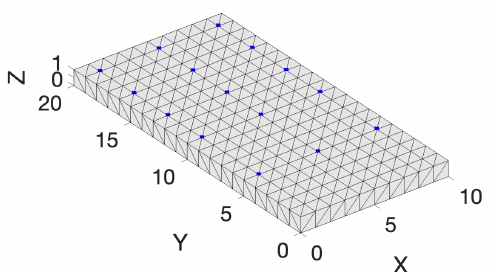
Figure 18. Sensors location expected allowing global model enrichment.